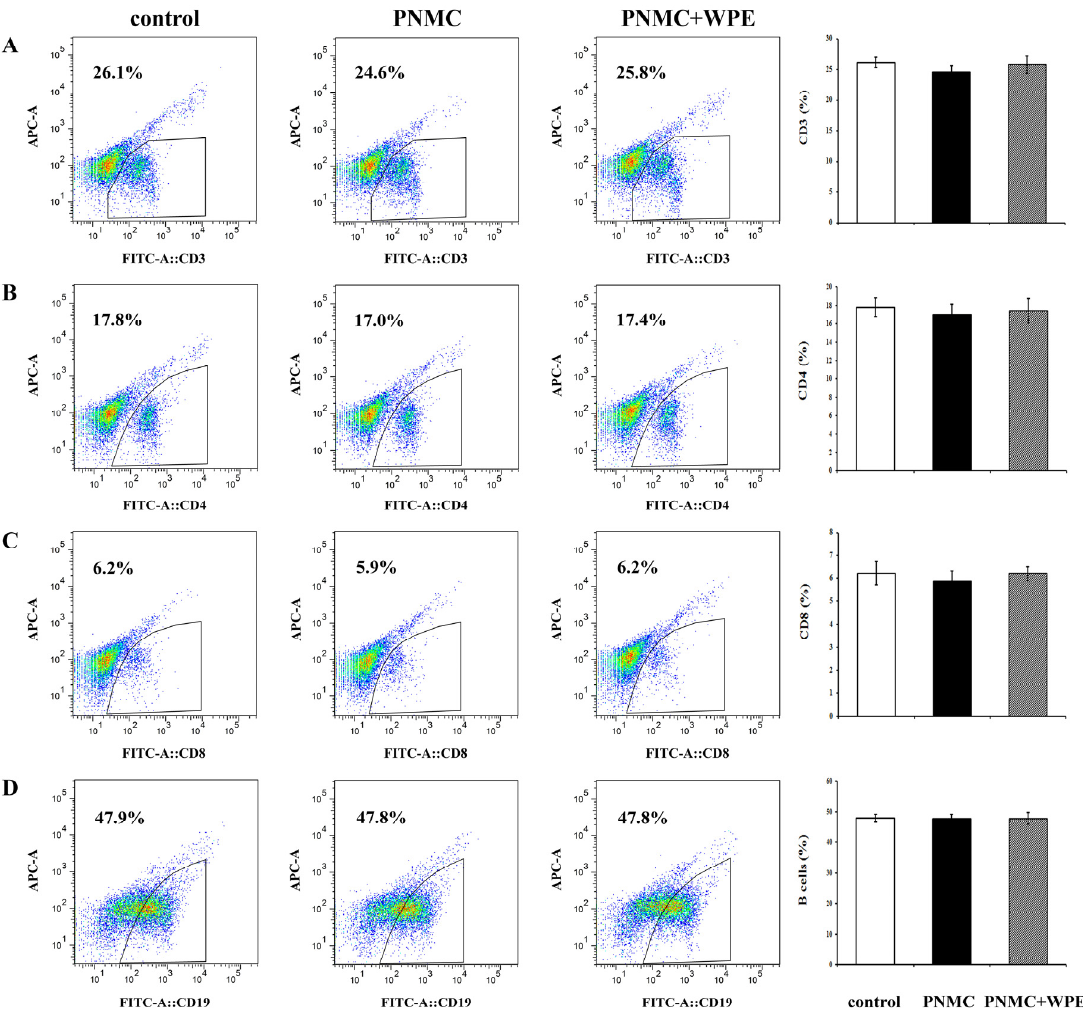
Figure 3. Percentages of various lymphocyte cell types as determined using flow cytometric analysis. ( A ) CD3 + T-cells; ( B ) CD4 + T-cells; ( C ) CD8 + T-cells; and ( D ) B-cells in cells exposed to medium only